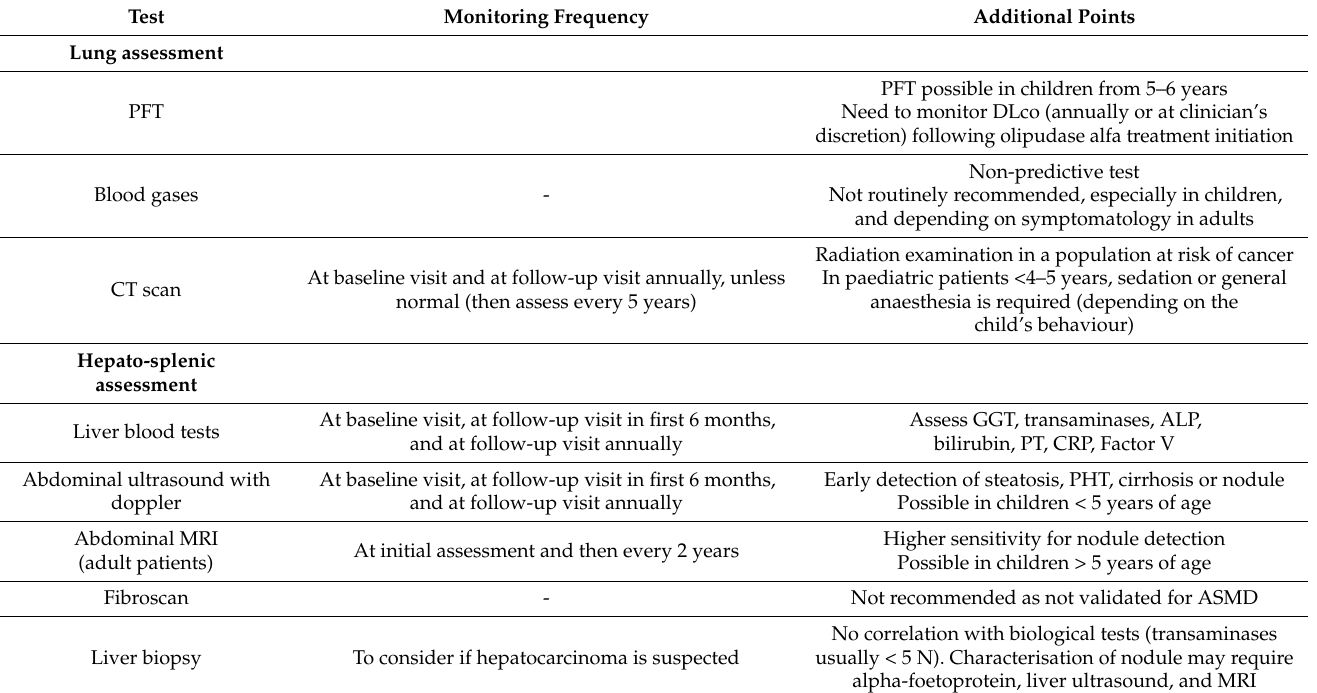
Table 3. Key monitoring parameters and frequency of assessment for patients with ASMD type B forms (NPD